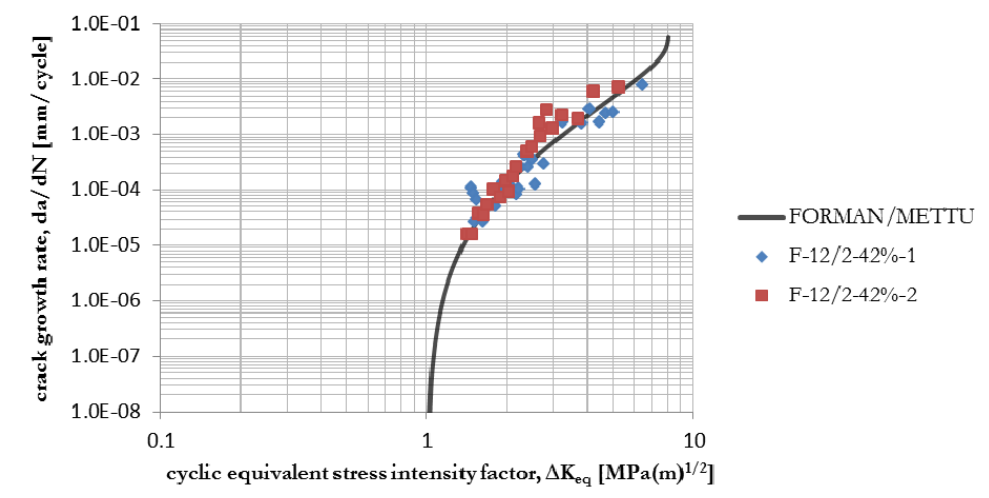
Figure 7: Fatigue crack growth rate data for compact tension specimens (90° fibre direction, R = 0.1).